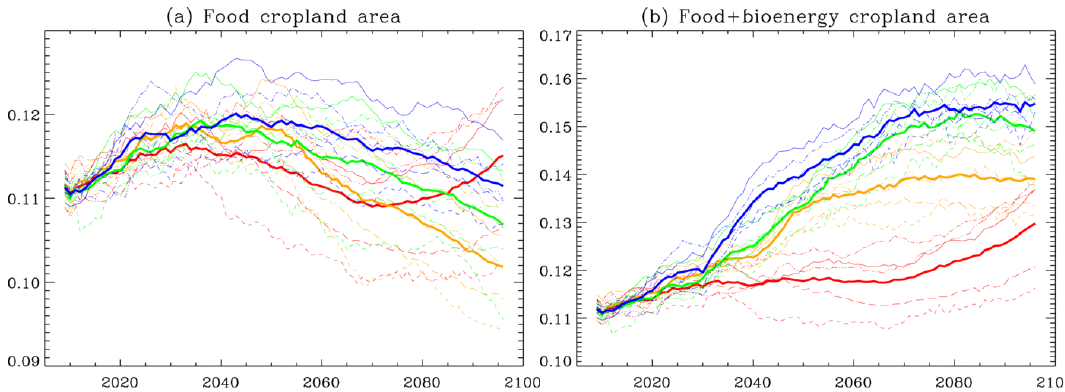
Figure 12. Time series of changes in cropland area based on the forcings of the five climate models. The vertical axis is the cropland area as a fraction of total land area. The results are for (a ) food cropland area and (b) food + bioenergy cropland area. Thin curves indicate the global average of results for each of the five climate model forcings. Thick curves show the overall average of results based on the five forcings. The colors indicate RCP2.6 (blue), RCP4.5 (green), RCP6.0 (orange), and RCP8.5